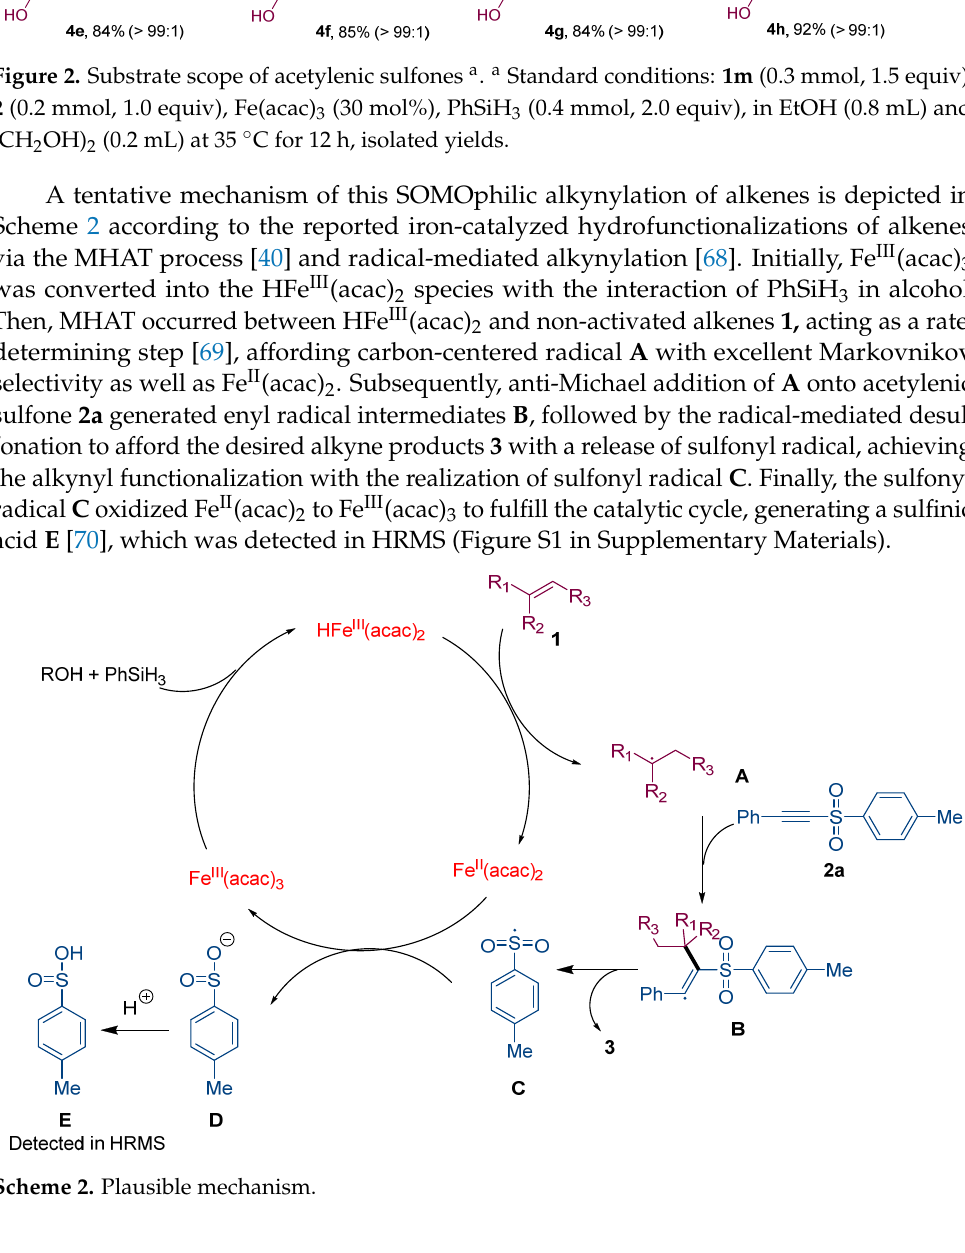
(CH 2 OH) 2 (0.2 mL) at 35 °C for 12 h, isolated yields.